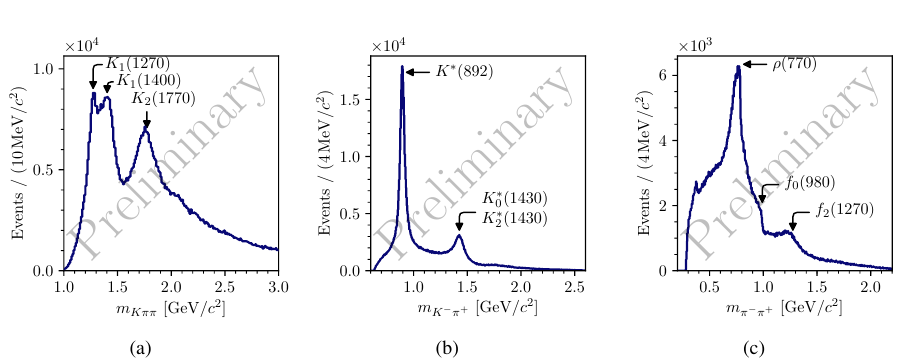
Figure 2: Invariant mass distribution of (a) the K − π − π + system, (b) the K − π + subsystem, and (c) the π − π + subsystems. The distributions are not corrected for acceptance e ff ects, which distort these